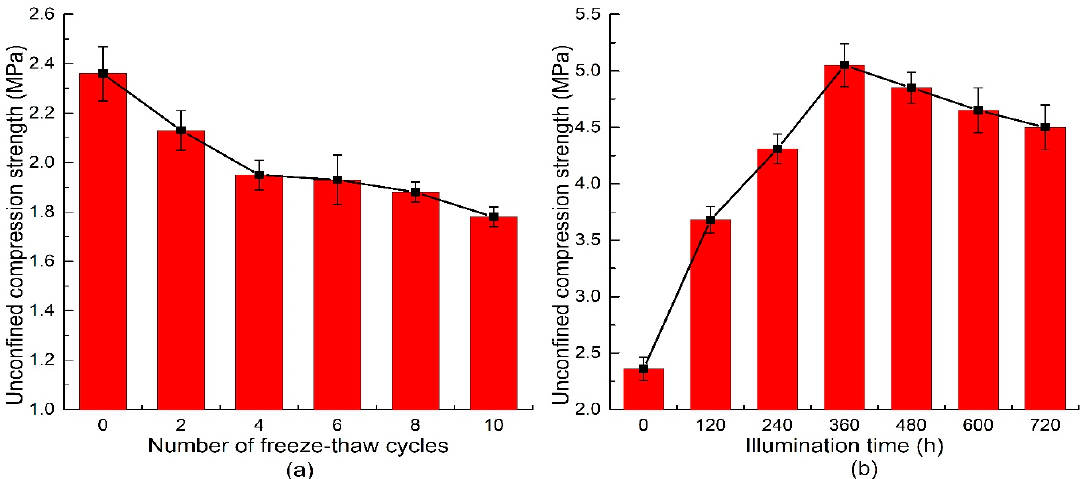
Figure 7. UCS vs. number of freeze-thaw cycles ( a ) and vs. illumination time ( b ) for soils tested.